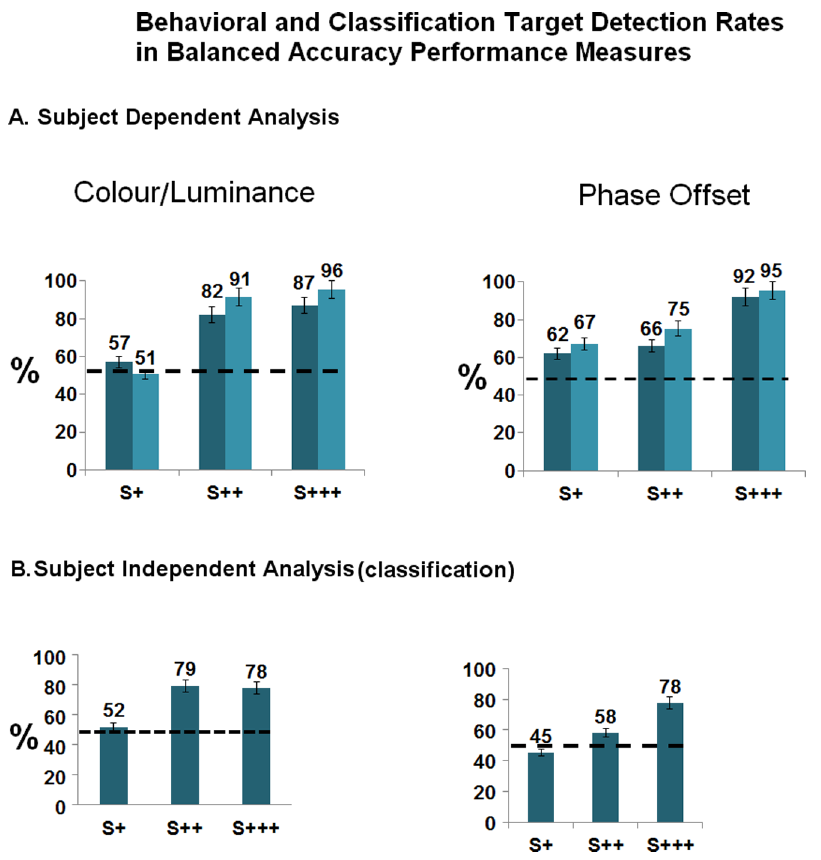
Figure 6. Behavioral and Singletrial waveform statistical classification performance in terms of (conservative) balanced accuracy – Experiments I & II - single trial statistical classification matches conscious perception and can be generalized across subjects. A. Behavioral and Subject dependent (within subject classification) LOO (leave one out) Classification Balanced Accuracy Rates for Target detection. Right: results for the Color/Luminance experiment. Left: results for the Phase Offset experiment. B. Subject independent (between subject classification) LOO (leave one out) Classification Balanced Accuracy Rates for Target detection. Right: results for the Color/Luminance experiment. Left: results for the Phase Offset experiment. Dashed lines depict chance level at 50%. Bars depict confidence intervals for the means at 95%.